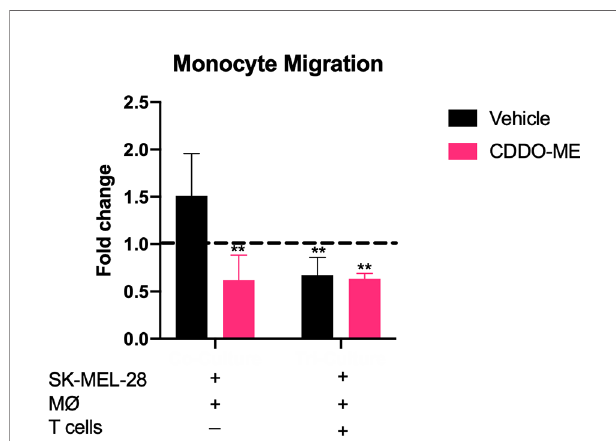
FIGURE 3 | CDDO-Me impairs monocyte migration in co-cultures. Human monocytes were incubated for 8 h at 37°C in the upper portion of Transwells in 100 m l of fresh media; feeder tray contained 150 m l of undiluted or 1:20 diluted co or tri-culture supernatants. Relative monocyte migration towards co- or tri-cultured supernatants was measured. Media were collected from cultures that were maintained as described in Figure 1 . Fold change is the ratio of sample fl uorescence (minus background fl uorescence) and internal control fl uorescence (M-CSF-differentiated MØ supernatant). Control fold change of media (RPMI) alone is indicated by dotted black line. **p < 0.01 vs. untreated control (two-way ANOVA). Data shown are representative of results obtained from analysis of 3 donors. Error bars represent standard deviation